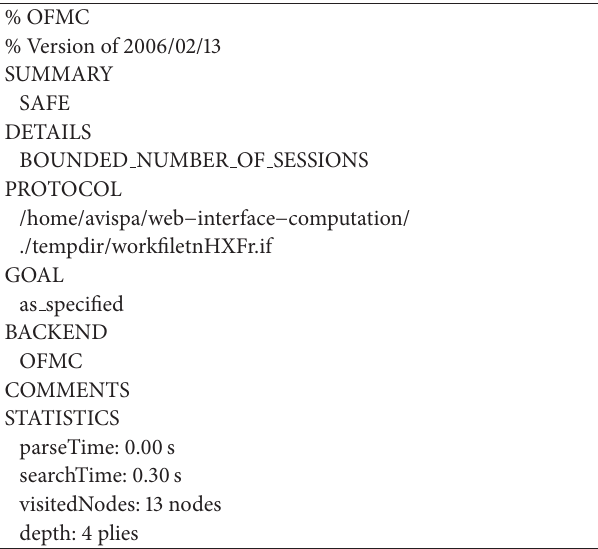
Table 7: The result of the analysis using OFMC of our